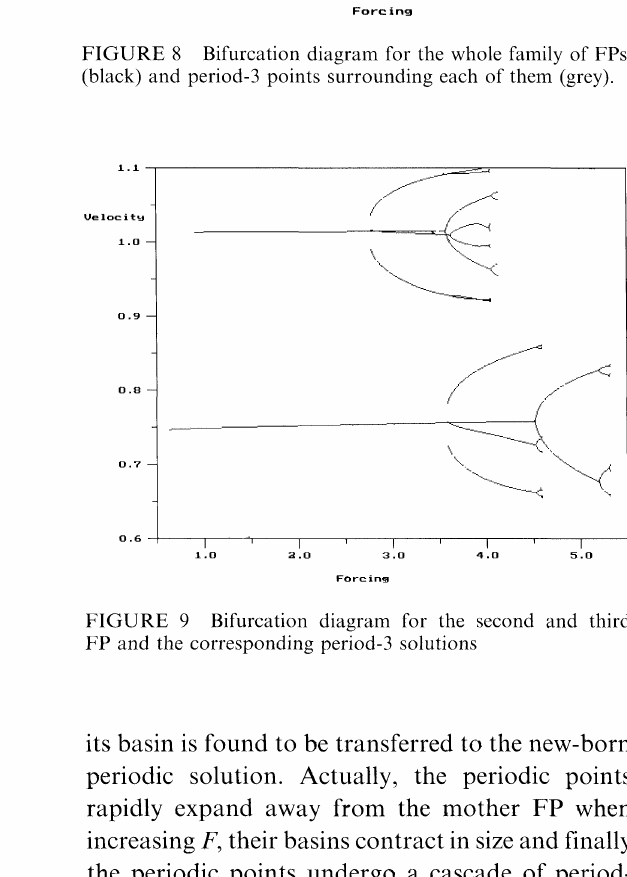
FIGURE 10 A strange attractor of the kicked pendulum for parameters/ 0.2 and F= 11.9.